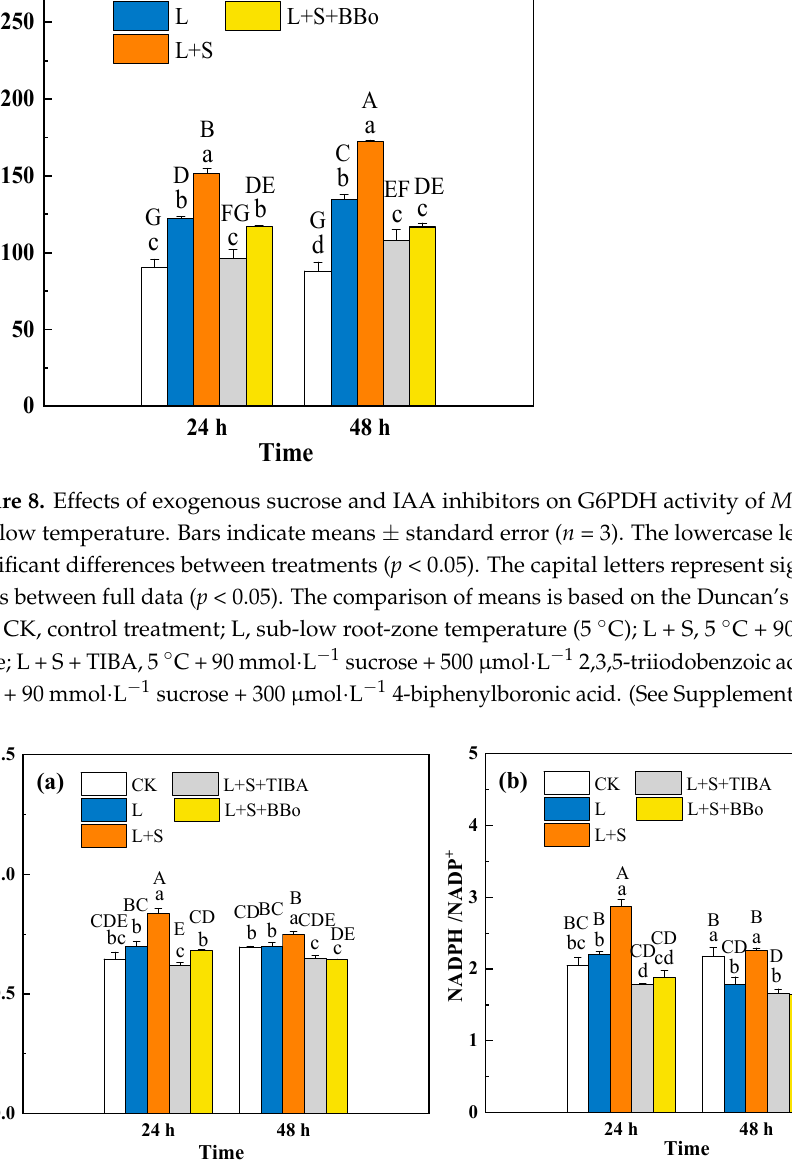
Figure 9. Effects of exogenous sucrose and IAA inhibitors on the NADPH contents ( a ) and NADPH/NADP + ( b ) of M. baccata under sub-low temperature. Bars indicate means ± standard error ( n = 3). The lowercase letters represent significant differences between treatments ( p < 0.05). The capital letters represent significant differences between full data ( p < 0.05). The comparison of means is based on the Duncan’s multiple range test. CK, control treatment; L, sub-low root-zone temperature (5 ◦ C); L + S, 5 ◦ C + 90 mmol · L − 1 sucrose; L + S + TIBA, 5 ◦ C + 90 mmol · L − 1 sucrose + 500 µ mol · L − 1 2,3,5-triiodobenzoic acid; L + S + BBo, 5 ◦ C + 90 mmol · L − 1 sucrose + 300 µ mol · L − 1 4-biphenylboronic acid. (See Supplementary Materials).